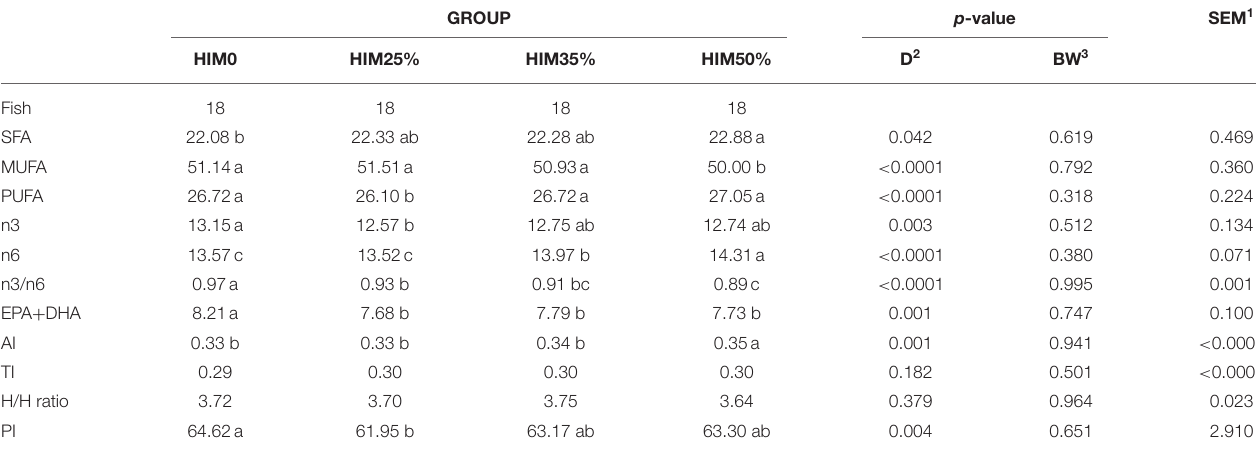
HIM0, fish meal group; HIM25, HIM35, and HIM50%, Hermetia illucens meal at 25, 35, and 50% substitution rates of fish meal groups, respectively. Fish: 18 per diet, 6 fish per tank, and 3 replications per